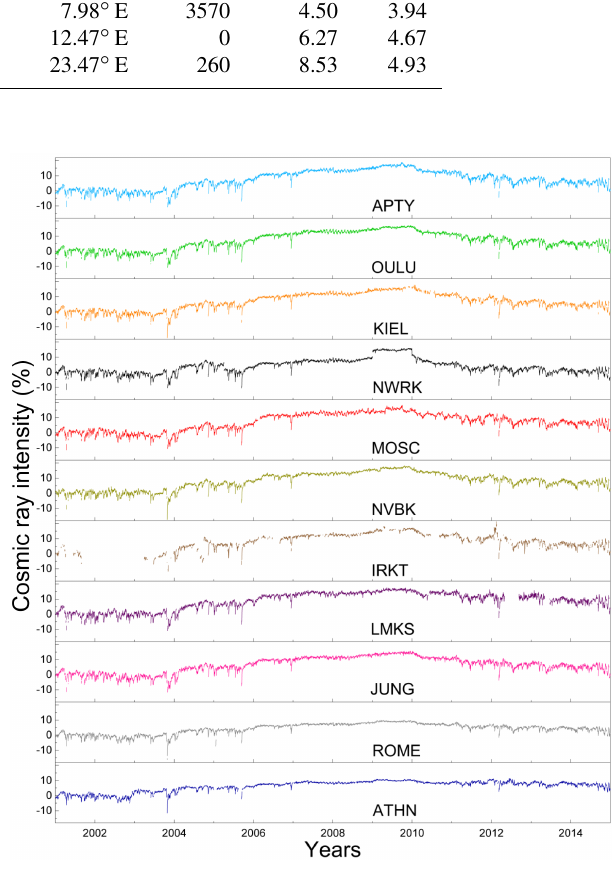
Figure 2. Time profiles of the cosmic ray intensity normalized to the mean value of the period 2001–2014 for all selected stations. for MOSC, 360 for NWRK, 362 for NVBK, 361 for OULU, and 360 for